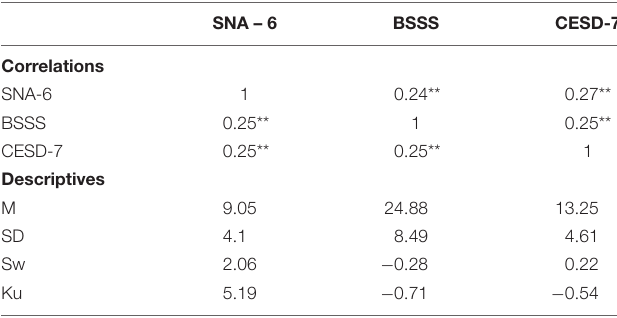
TABLE 6 | Latent correlations and descriptive statistics for